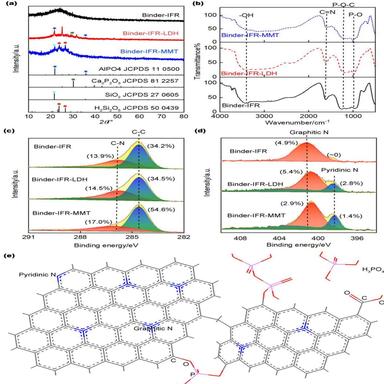
(a) XRD patterns of the char layers (green boxes). (b) FTIR spectra of the char layers. XPS spectra of the char layers showing: (c) C1s, (d-) N1s. (e) Schematic illustration of the char layer structure derived from Binder-IFR. (A colour version of this figure can be viewed online.)